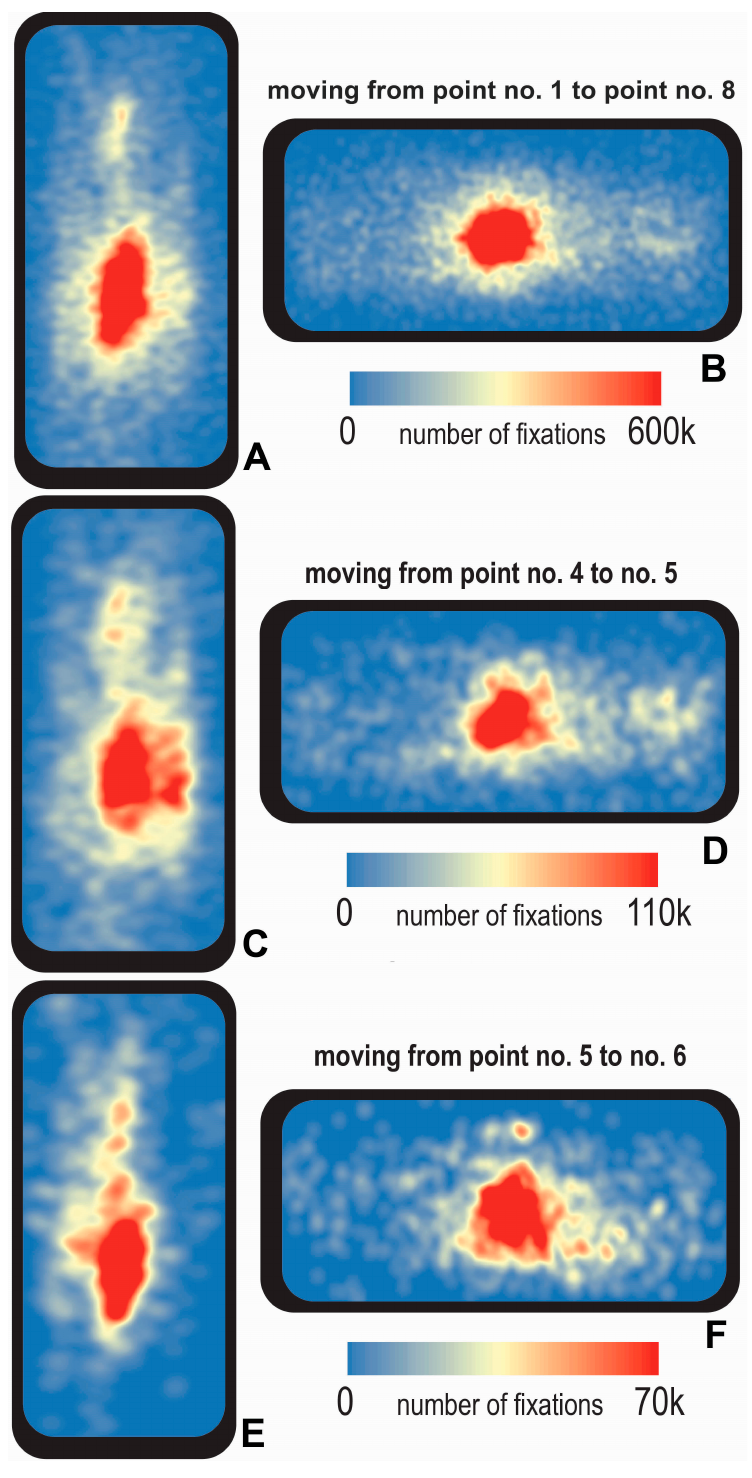
Figure 9. Heat map with participant fixation locations on smartphone: ( A )—portrait orientation for the movement from monuments 1 to 8; ( B )—landscape orientation for the movement from monuments 1 to 8; ( C )—portrait orientation for the movement from monuments 4 to 5; ( D )—landscape orientation for the movement from monuments 4 to 5; ( E )—portrait orientation for the movement from monuments 5 to 6; ( F )—landscape orientation for the movement from monuments 5 to 6.